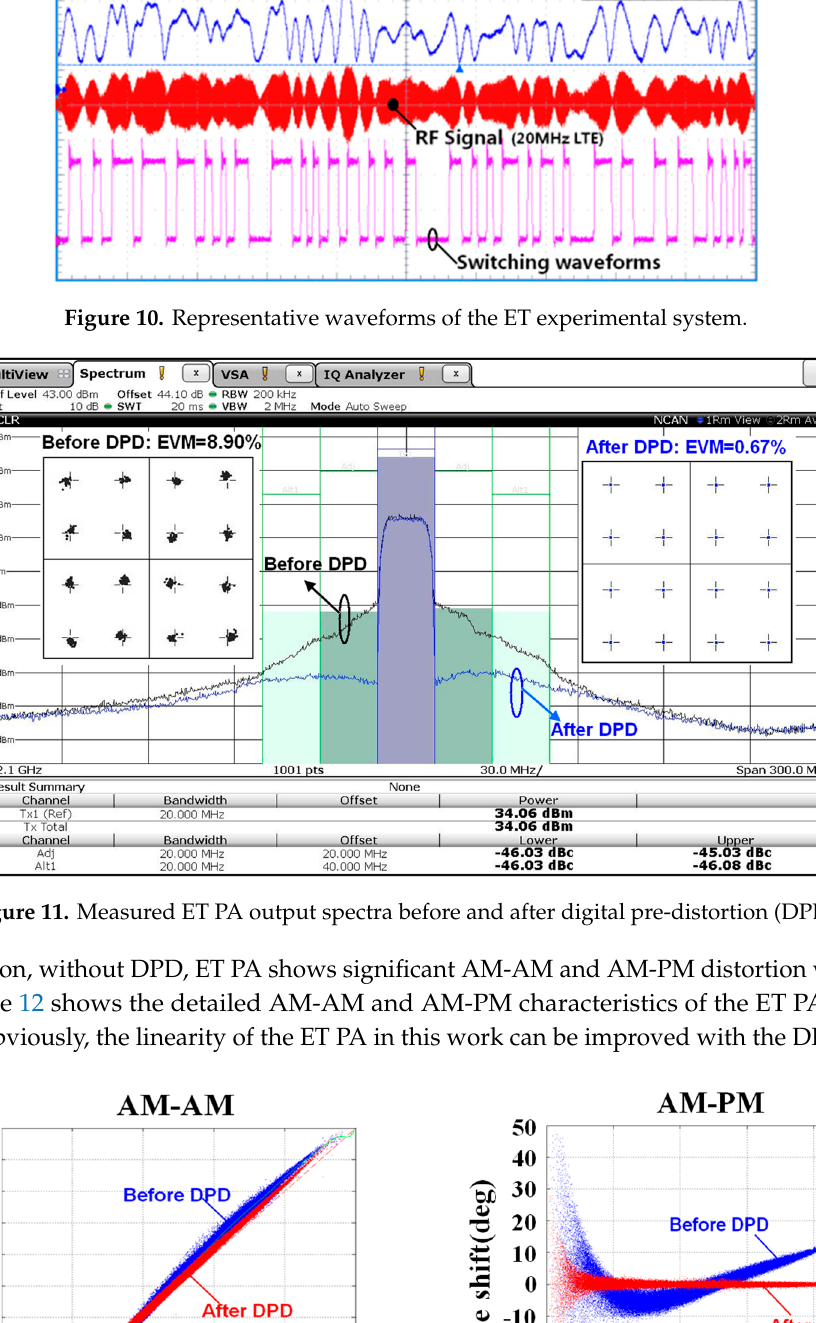
Figure 10. Representative waveforms of the ET experimental system.